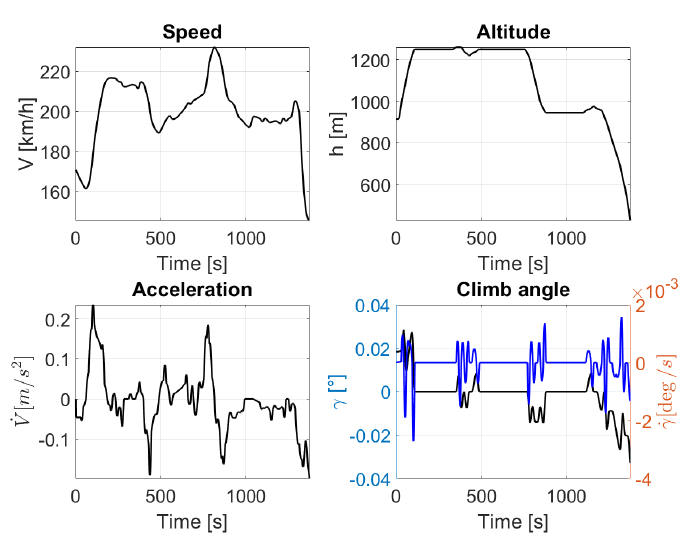
Figure 3. Mission pro fi le. Figure 3. Mission